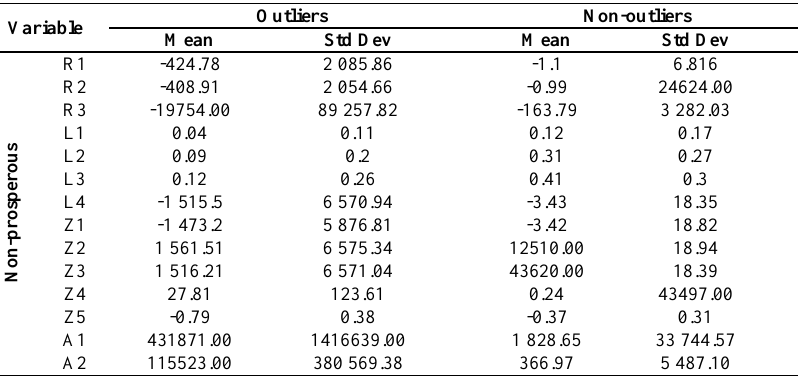
Table 5. t-test for equality of means between prosperous and non-prosperous